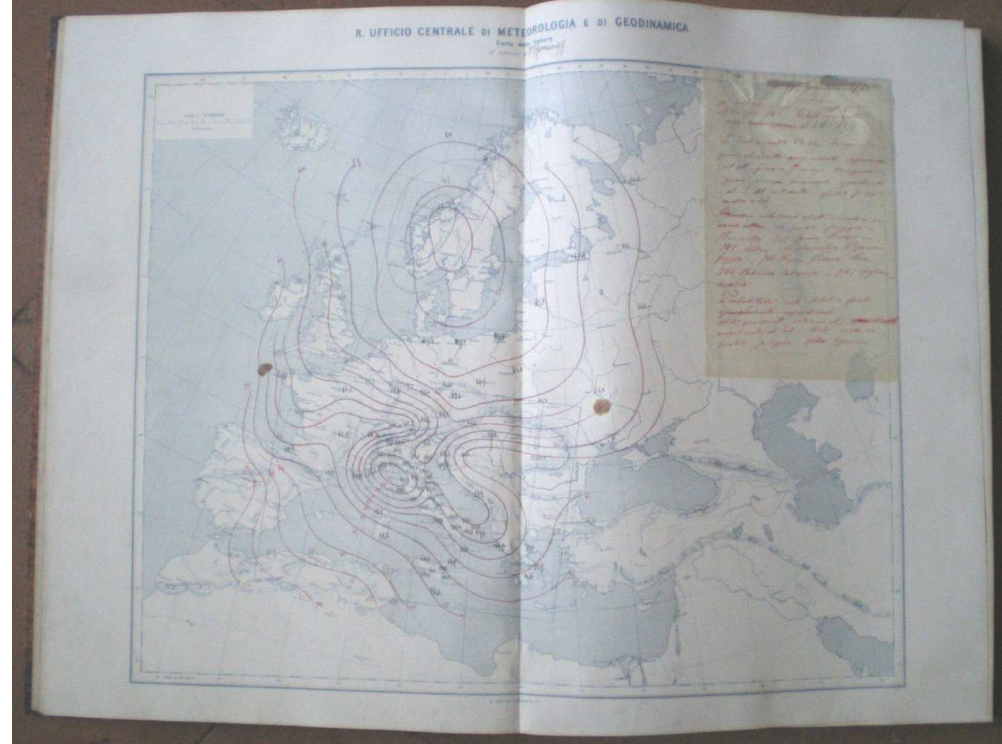
Fig. 1 Figure 1. Sample of an early daily isobaric chart. A brief note about the weather forecast for the next day was added to each